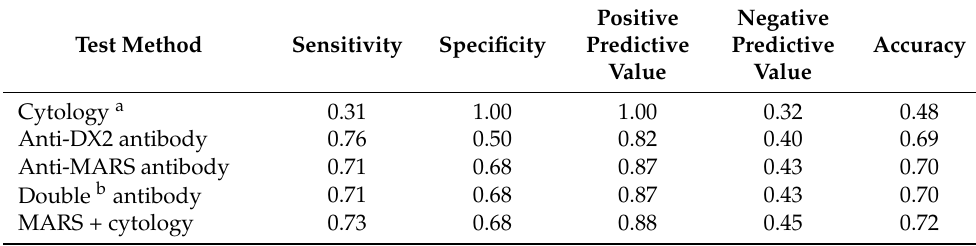
Table 4. Diagnostic performance of cytology and staining methods.